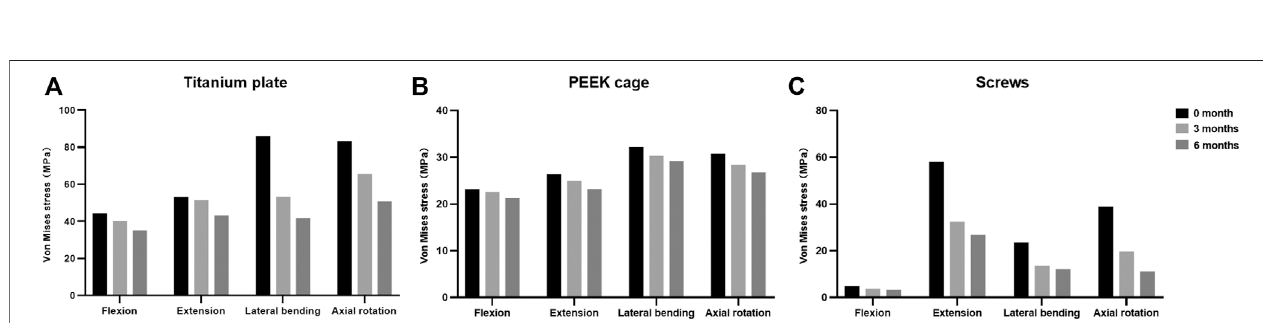
FIGURE 5 | Maximal Von Mises stress at the surfaces of (A) titanium plate, (B) PEEK cage, and (C) screws at different fusion stages.